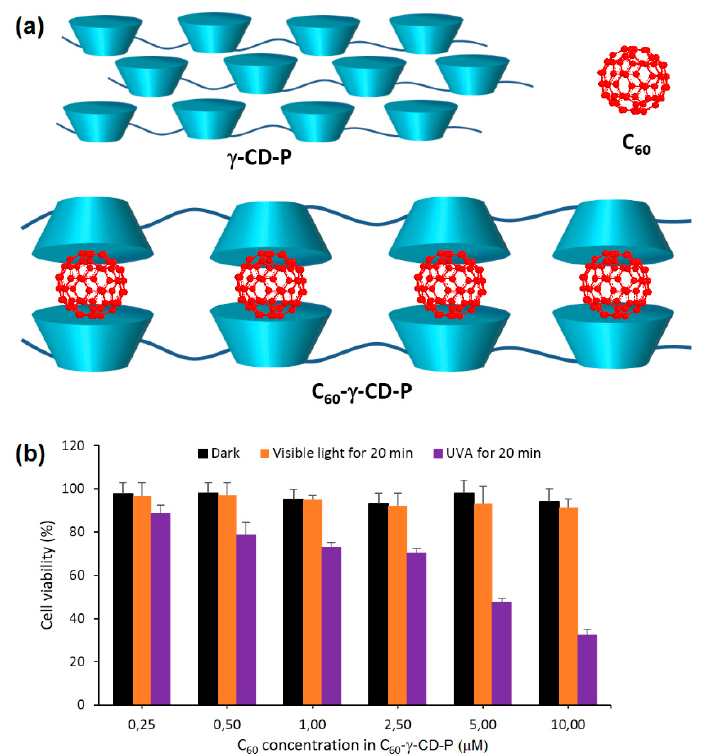
Figure 75. ( a ) Schematic illustration of γ -CD polymer ( γ -CD-P), C 60 , and C 60 - γ -CD-P. ( b ) Effect of different concentration of C 60 - γ -CD-P exposure on the B16-F10 cell viability irradiated with UV-A from two fluorescent PUV-A lamps (Philips, PL-L36W) or two cool white visible light lamps (Philips, TLD36W) for 20 min. Adapted from Zhang; Gong; Liu; Piao; Sun; Diao [223].